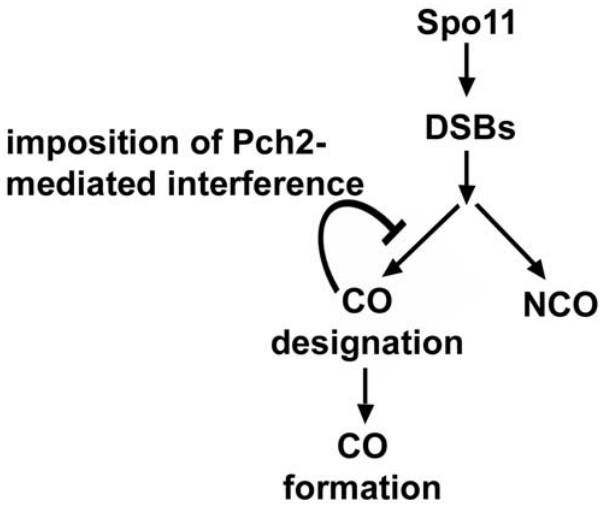
Figure 7. Model for interference-regulation of the CO vs. NCO decision. We propose that Pch2 acts to inhibit CO designation in a chromosomal region in response to a prior crossover-designated recombination event in that region. See text for details.